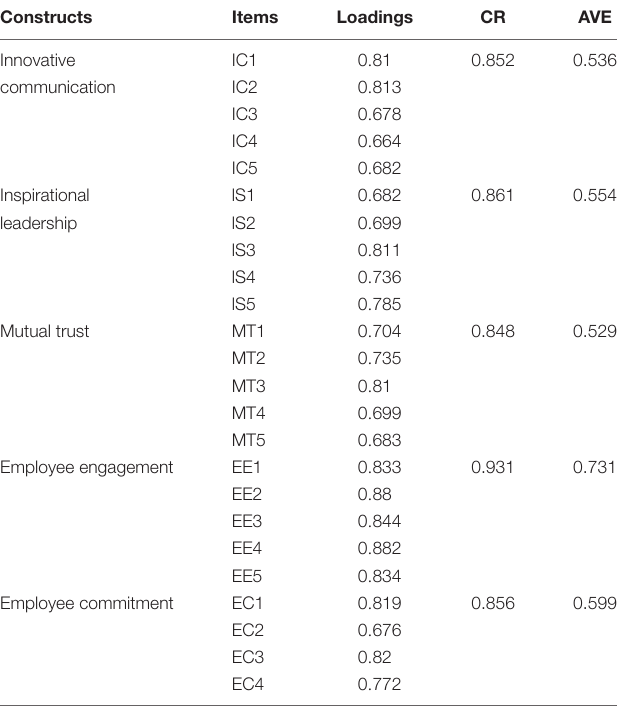
TABLE 1 | Construct reliability and validity.